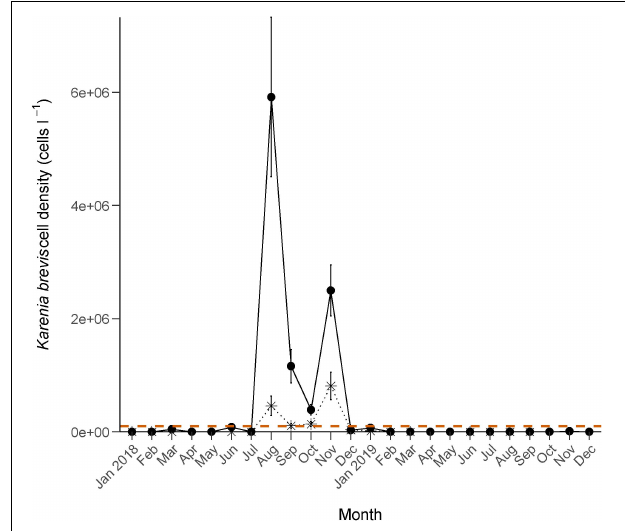
FIGURE 2 | Monthly Karenia brevis cell densities (mean ± se) sampled from January 1, 2018–December 31, 2019. Symbols: • = samples collected anywhere in the Sarasota Bay study area; (cid:84) = samples collected at fish sampling stations; horizontal dashed line = 100,000 cells l − 1 threshold for ichthyotoxic